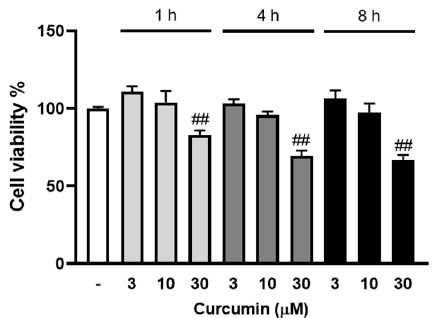
Figure 2. The effect of curcumin on VSMC viability. VSMCs were cultured in 96-well plates and treated with 3, 10 and 30 µ M curcumin (in 90 µ L media) for 1, 4 and 8 h followed by the AlamarBlue viability assay. The results are representative of three independent experiments (presented as mean ± SEM). Statistical significance was determined by one-way ANOVA, followed by least significant difference post-hoc analysis. ## p < 0.01 versus untreated control.